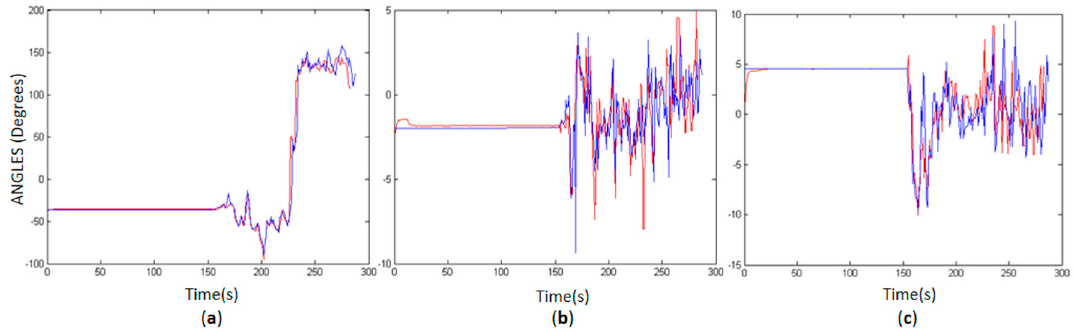
Figure 6. MPU 6050 attitude accuracy, comparing VN-100 Rugged IMU (blue) and MPU6050 (red): yaw ( a ); pitch ( b ); and roll ( c ). yaw ( a ); pitch ( b ); and roll ( c